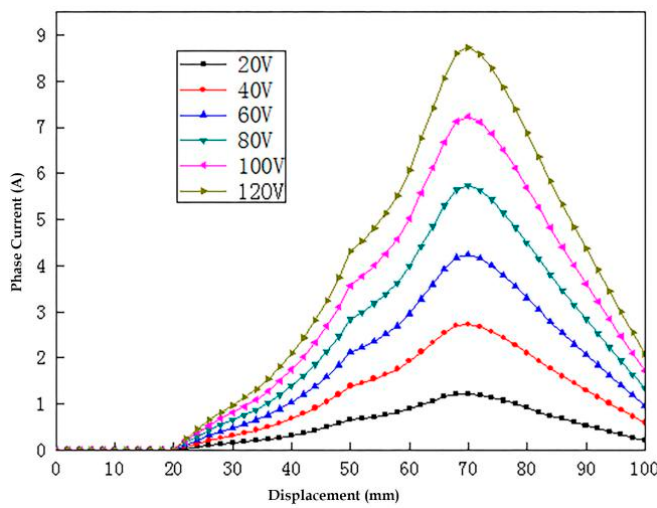
Figure 12. The phase currents at different voltage levels is shown in Figure 12.